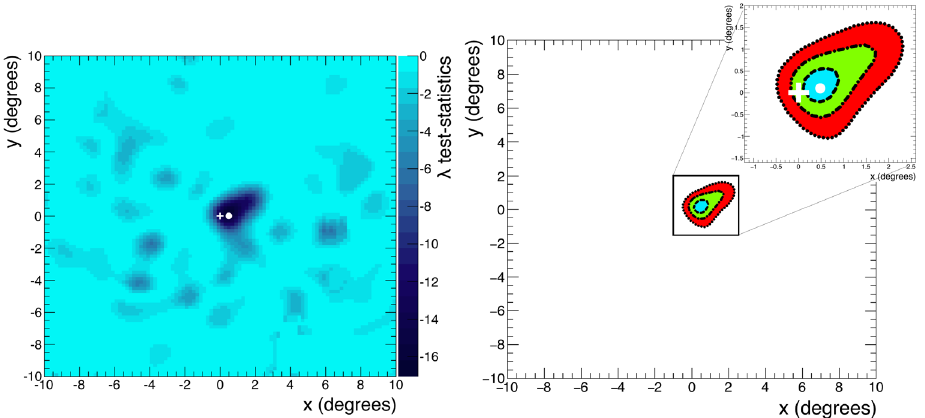
Figure 3. Left: Measured distribution of the test statistic λ from equation (1) around the nominal position of the Moon, assumed in the center of the FoV. Right: Contour plots for di ff erent confidence levels (cyan / dashed: 68.27%; green / dot-dashed: 95.45%; red / dotted: 99.73%). In both plots, the white dot represents the position of λ min while the cross